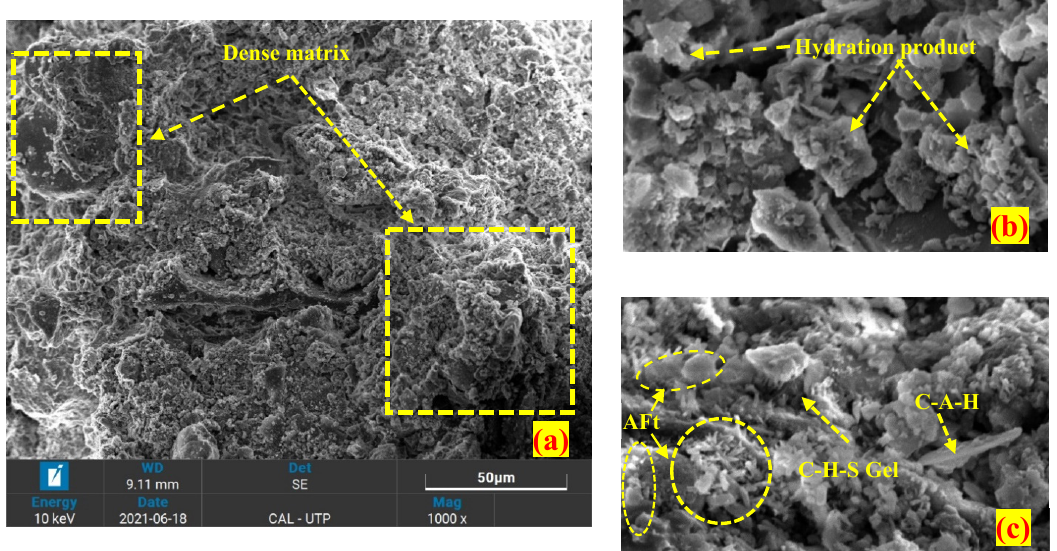
Figure 3. SEM image of 28-day cured OPC stabilized peat ( a ) 1000×, ( b ) 8000×, ( c ) 10,000×.